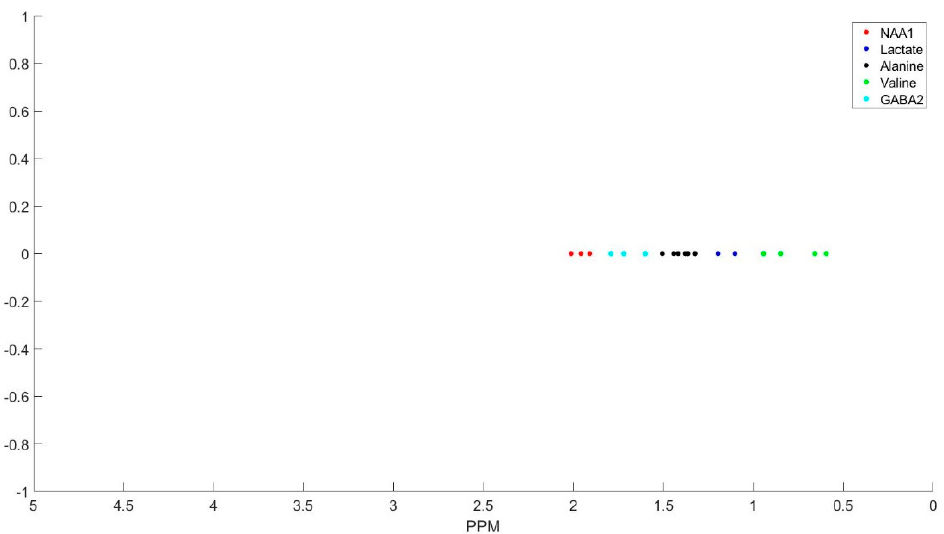
Figure 6. Peak location of basis sets of a decomposed FID signal of subject shown in the Figure 2.